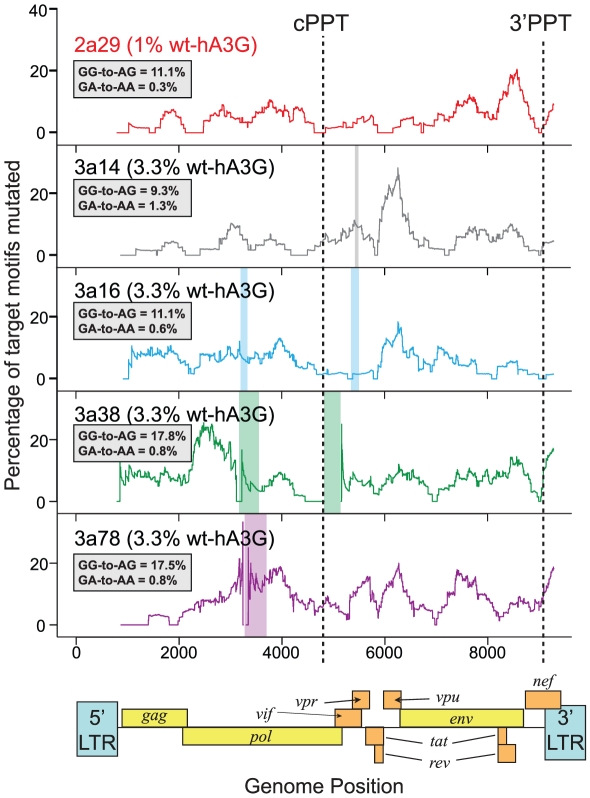
Hypermutation is induced throughout HIV-1 genomes mutated by one wt-hA3G unit.We generated near-full length sequences (gag to 3′LTR) of a subset of hypermutated viruses from the lower wt-hA3G titrations (1% wt-hA3G:99% E259Q-hA3G (2a29) or 3.3% wt-hA3G: 96.7% E259Q-hA3G (3a14, 3a16, 3a38, 3a78)) and determined the induced mutations by comparing the sequences with the known parental virus sequence. Hypermutation profiles were made by calculating the number of GG and GA dinucleotides mutated to AG and AA, respectively, in 400bp sliding windows to the 3′ of the base under consideration. The positions of the central polypurine tract (cPPT) and 3′PPT are indicated; the overall GG-to-AG and GA-to-AA mutation rates in each sequence are indicated in the inset boxes. Colored rectangles indicate gaps in sequences.